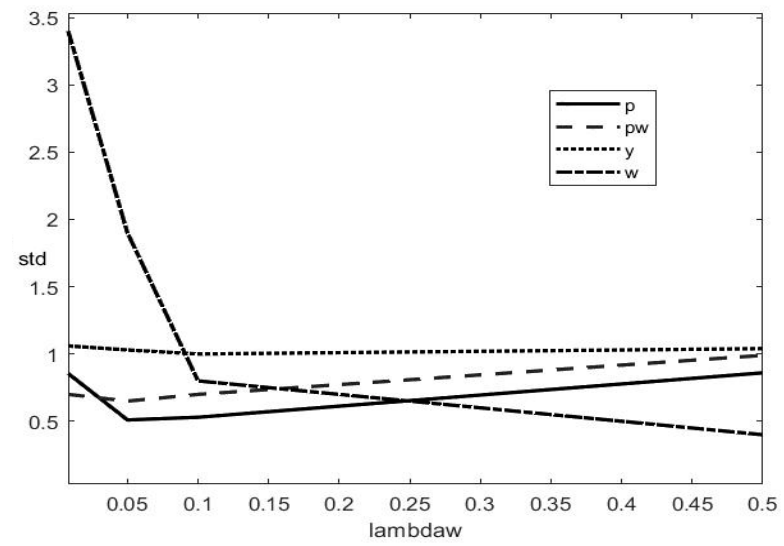
Figure 7. Standard deviation (std) of price inflation ( p ), wage inflation (pw), output gap (y), and real wage gap (w) as a function of wage flexibility (lambdaw). Model with rigid wages and prices with monetary policy parameters given in Table 2 ( φ π = 1.5, φ w = φ y = 0.5 )